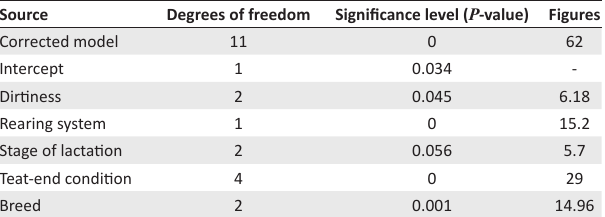
TABLE 8: Causal relationships between mastitis risk factors and mastitis prevalence. Source